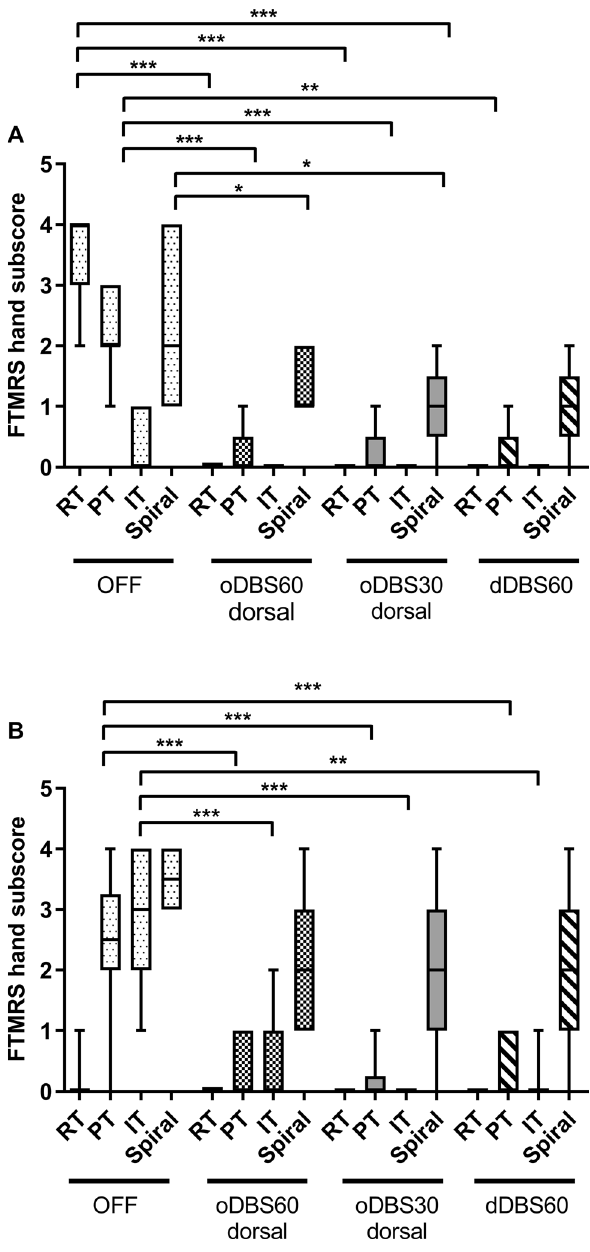
Figure 5. Response of tremor subtypes to the different stimulation conditions in PD and ET. RT: rest tremor, PT : postural tremor, IT : action / intention tremor, Spiral : small spiral (item 12 of the FTMRS). Note that data